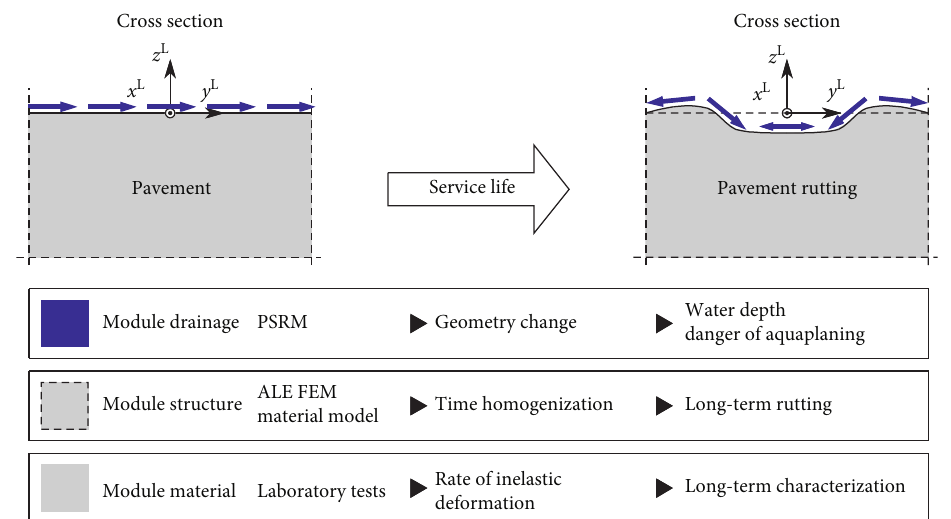
Figure 1: Overview of the modular unidirectional hydromechanical investigation for deformable asphalt pavements subjected to rut formation during their service life: pavement surface runoff model (PSRM) and arbitrary Lagrangian–Eulerian finite element method (ALE FEM).